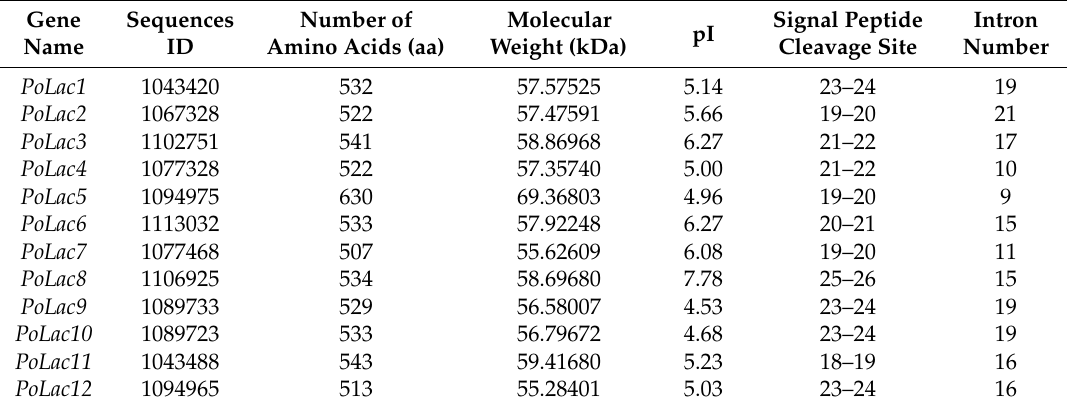
Table 1. The predicted and tallied physiochemical properties of 12 putative laccases genes in P. ostreatus